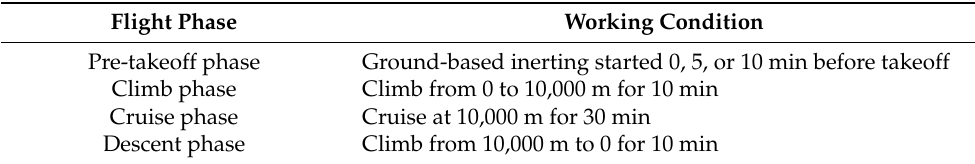
Table 3. Working conditions of the flight phases.